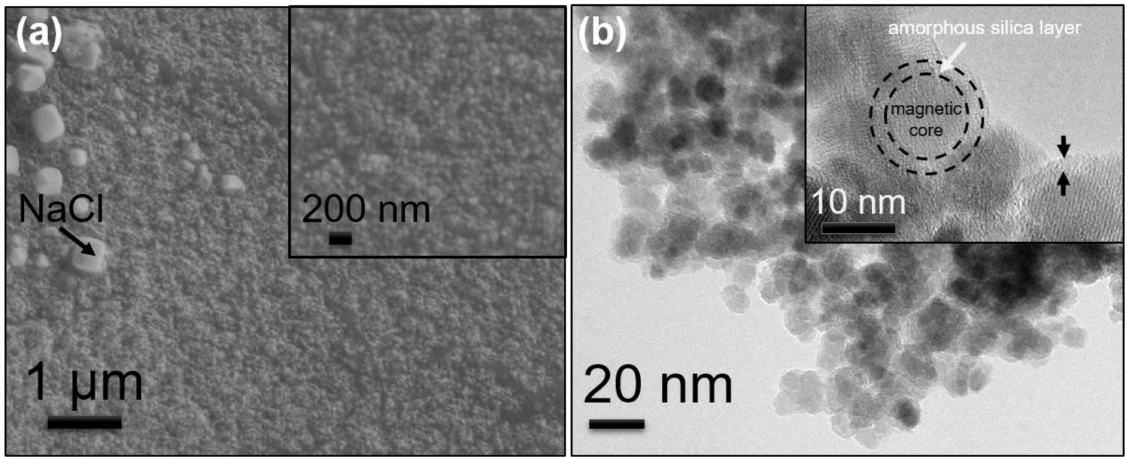
Figure 4. ( a ) FE-SEM image and ( b ) TEM image at lower and higher magnification (shown in the inset) for MNPs@SiO 2 @Lys. The black arrows in the inset of ( b ) denote the silica